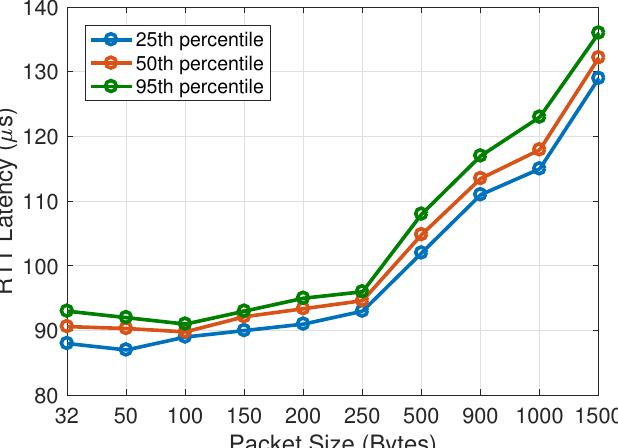
Figure 5. Percentile of latency on the Ethernet-based multi path fronthaul as a function of different packet